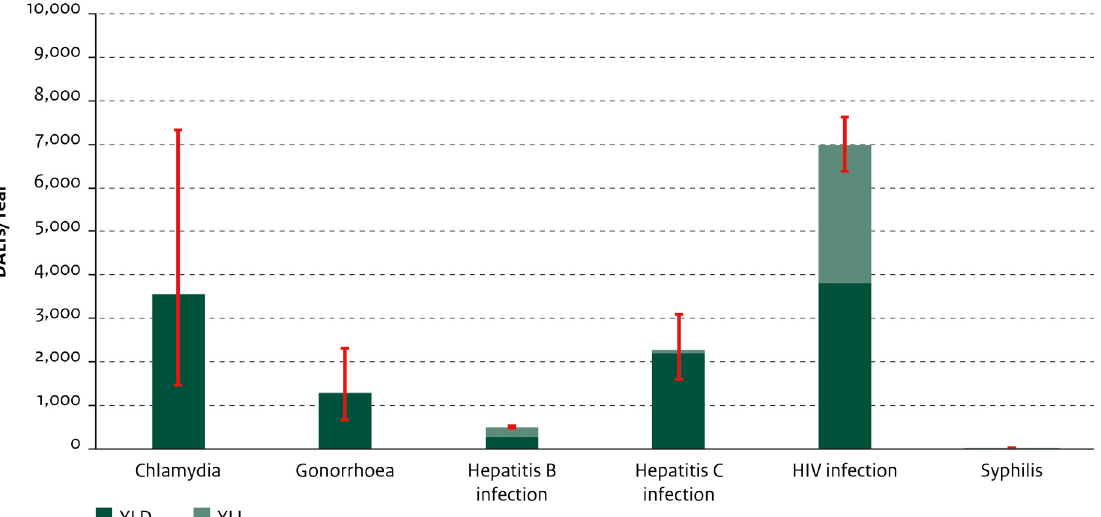
Fig 1. Average annual disease burden in the Netherlands in 2007 – 2011 for new cases of sexually-transmitted infections. YLD and YLL components are shown separately. Red lines indicate 95% uncertainty intervals.(DALY = Disability-Adjusted Life Year, YLD = Years Lived with Disability, YLL = Years of Life